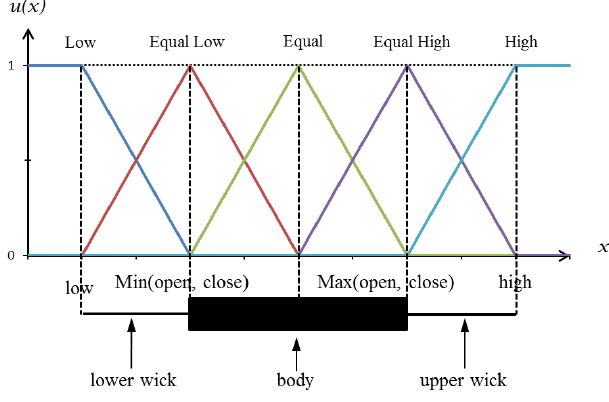
Figure 4. Membership function of the linguistic variables for open and close styles.